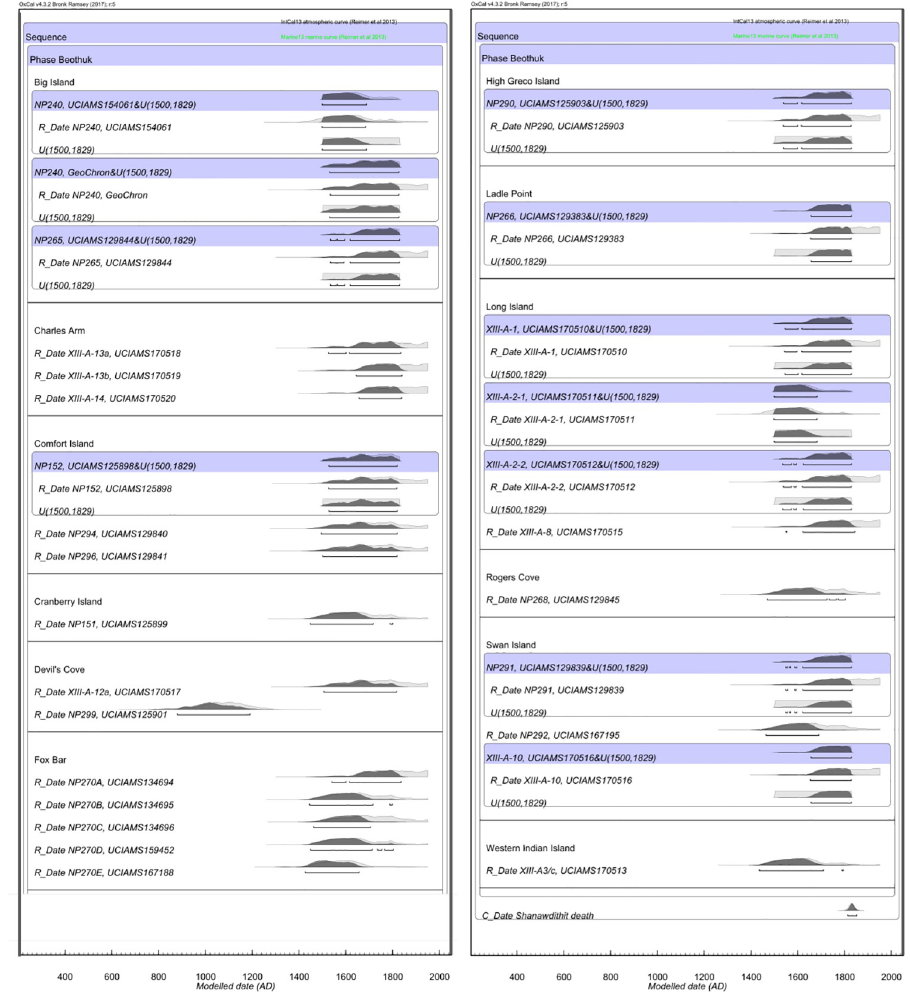
Fig 3. Calibrated Beothuk dates modelled with a date constraint of AD 1829. The purple shaded bars specify the parameters used to model the radiocarbon dates. Where the skeletal remains were found with modified European artifacts or trade items, the dates were constrained between AD 1500 and 1829. Includes published radiocarbon dates from Duggan et al. 2017.